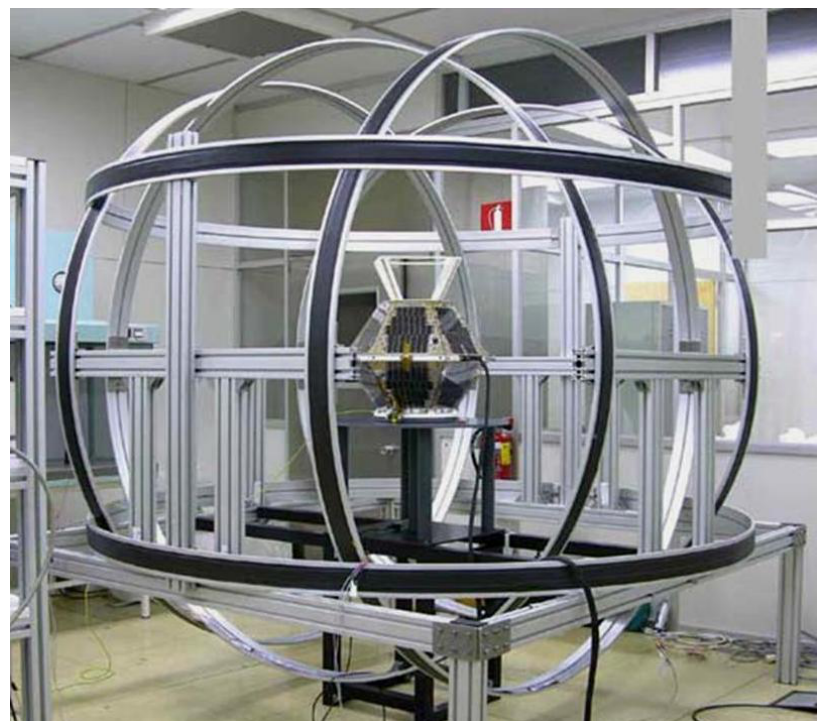
Figure 9. NS-1B Magnetometer calibration setup.